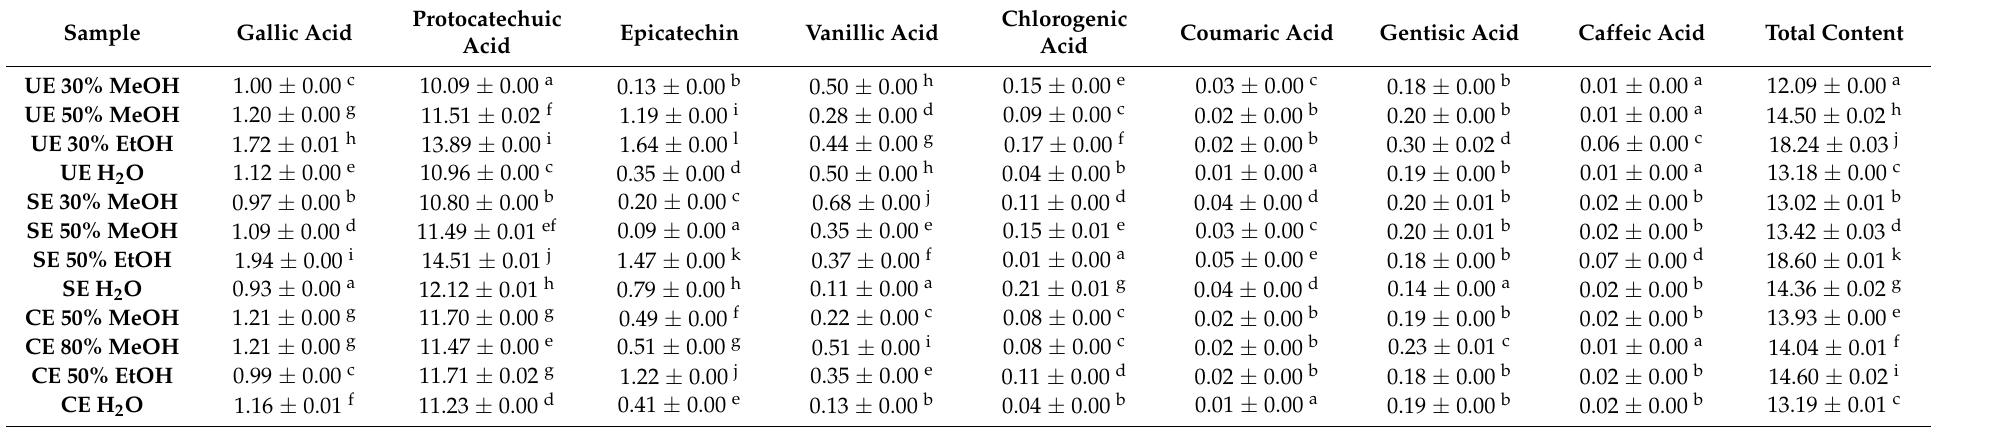
Table 2. HPLC analysis of individual phenolic compounds in beetroot